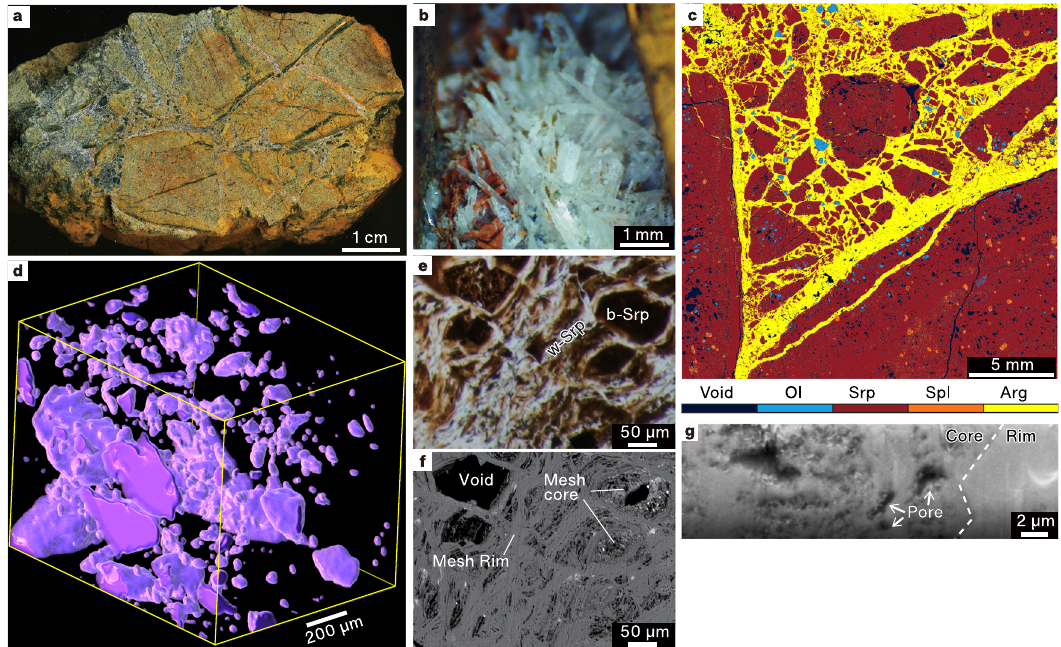
Fig. 2 In situ aragonite crystals from 6429m below sea level from the YK17-14 Leg 2 cruise (6K#1507-R14). a Slice of serpentinite consisting of highly brecciated serpentine that is cemented by aragonite. b Euhedral aragonite in serpentine fractures, which implies in situ aragonite growth. c Mineral-phase map created from an elemental map using k -means clustering. Ol = olivine; Srp = serpentine; Spl = spinel; Arg = aragonite. d Three-dimensional distribution of clasts (serpentine and olivine) in an aragonite vein (total volume: 1.13 mm × 0.90 mm × 0.89 mm). Photomicrograph ( e ) and back-scattered electron image ( f ) of serpentine mesh texture, which consists of porous brown serpentine mesh cores (b-Srp) and non-porous white serpentine mesh rims (w-Srp). g FIB – SEM image showing the porosity contrast between the serpentine mesh core and rim.